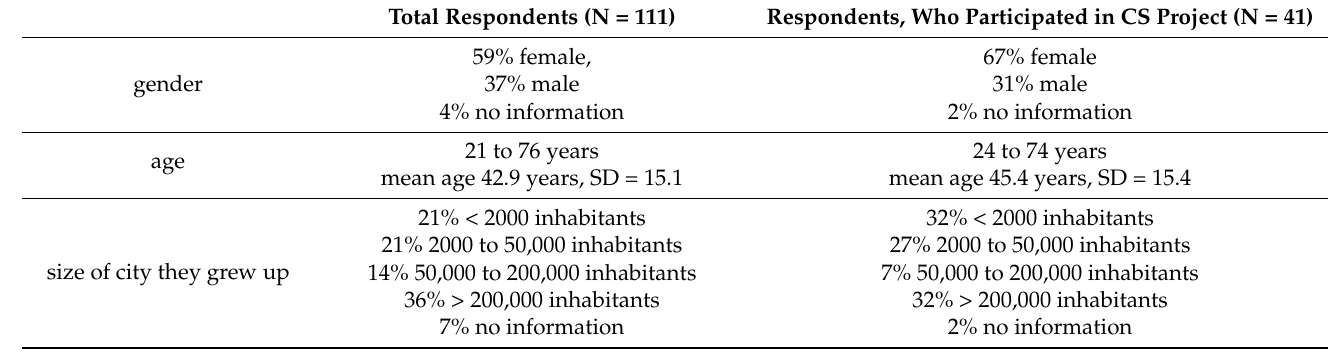
Table 2. Demographics of respondents (N = 111) and respondents, who participated in the pollinator CS project (N = 41).